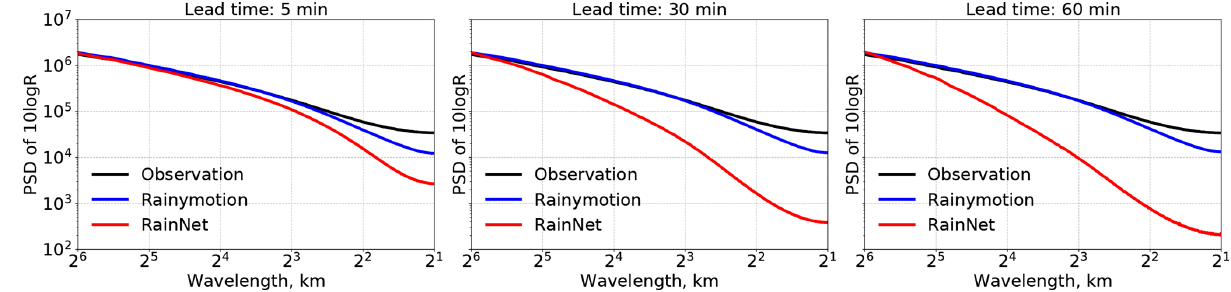
Figure 5. PSD averaged over all verification events and nowcasts for lead times of 5, 30, and 60min.